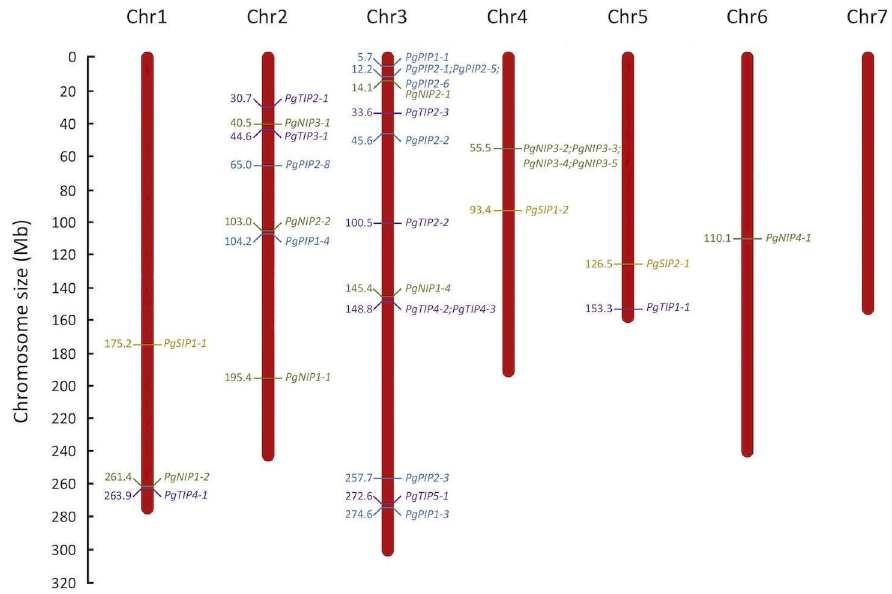
Fig 3. Distribution of aquaporin genes in the pearl millet genome. The seven chromosomes (Chr) of the pearl millet genome are represented according to their size in megabase (Mb). Positions of PIP, TIP, SIP and NIP genes are represented in blue, purple, orange and green, respectively. PgPIP2-7 , which is localized on scaffold763, is not represented.